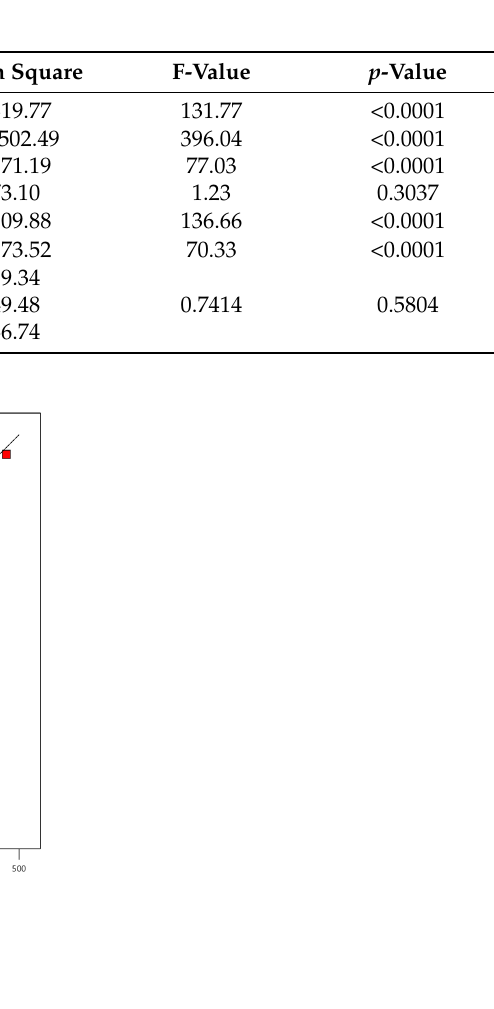
( b ) Figure 2. The plot between actual and predicted values ( a ) and the plot between residual and run ( b ).